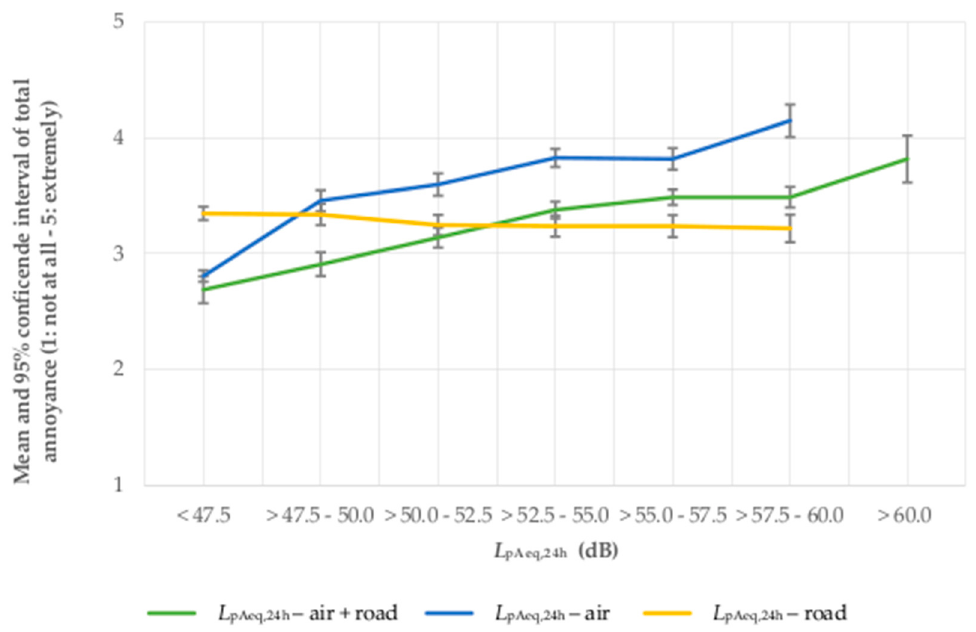
Figure 3. Total noise annoyance by aircraft + road traffic, aircraft and road traffic noise in association with the 24-h average sound pressure level, L pAeq,24h of aircraft + road traffic, aircraft and road traffic noise.